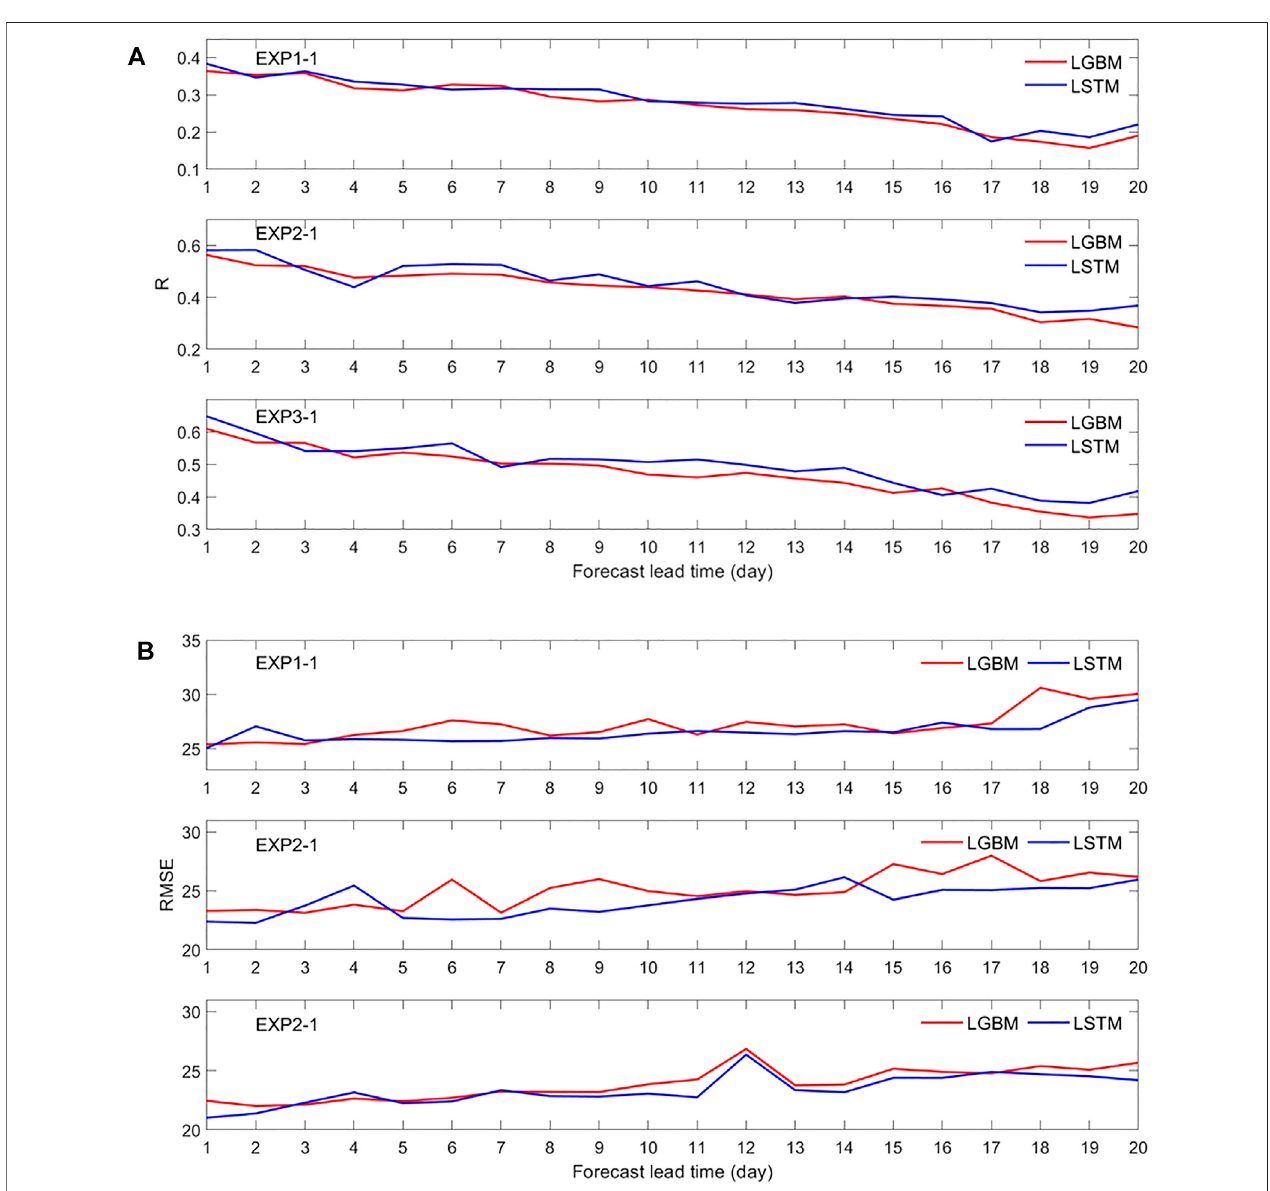
FIGURE 10 | Comparison of results from EXP 1 to EXP 3 with the actual condition for LGBM and LSTM models (A) R (the 95% con fi dence level is 0.18) and (B) RMSE.